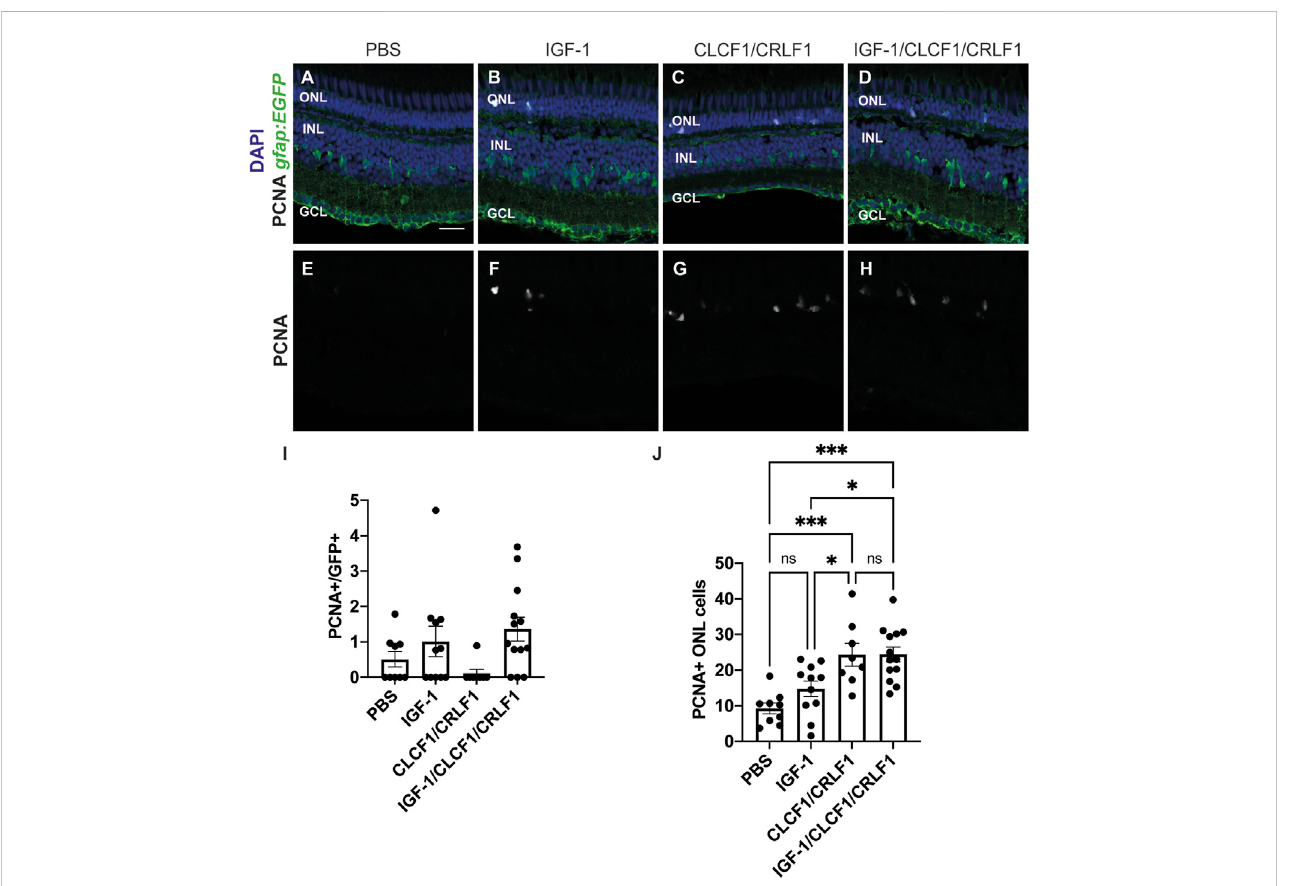
FIGURE 8 Co-injection of CLCF/CRLF and IGF-1 does not induce additional proliferation. (A – D) Single confocal images from albino; Tg[gfap:EGFP] nt11 zebra fi sh which were intravitreally injected every 12 h with either PBS (A) , IGF-1 (B) , CLCF1/CRLF1 (C), or a combination of IGF-1 and Clcf1/Crlf1a (D) for 72 h. Sections were labeled for GFP and PCNA to assess proliferating Müller glia and nuclei were counterstained with DAPI (E, F, G, H) . (I) Quanti fi cation showing no change in the number of PCNA-positive Müller glia within the INL of IGF-1 and IGF-1/CLCF1/CRLF1-injected retinas. (J) Quanti fi cation showing signi fi cant difference in the number of PCNA-positive cells within the ONL of IGF-1 and IGF-1/CLCF1/CRLF1-injected retinas. One-way ANOVA with Tukey post hoc , IGF-1/CLCF1/CRLF1 vs. PBS p = 0.0001, CLCF1/CRLF1 vs. PBS p = 0.0007, IGF-1 vs. CLCF1/CRLF1 p = 0.0362, IGF-1/CLCF1/CRLF1 vs. IGF-1 p = 0.0127. n ≥ 8. Mean ± SEM, * p < 0.05,*** p < 0.001. ONL, outer nuclear layer, INL, inner nuclear layer, GCL, ganglion cell layer. Scale bar represents 20